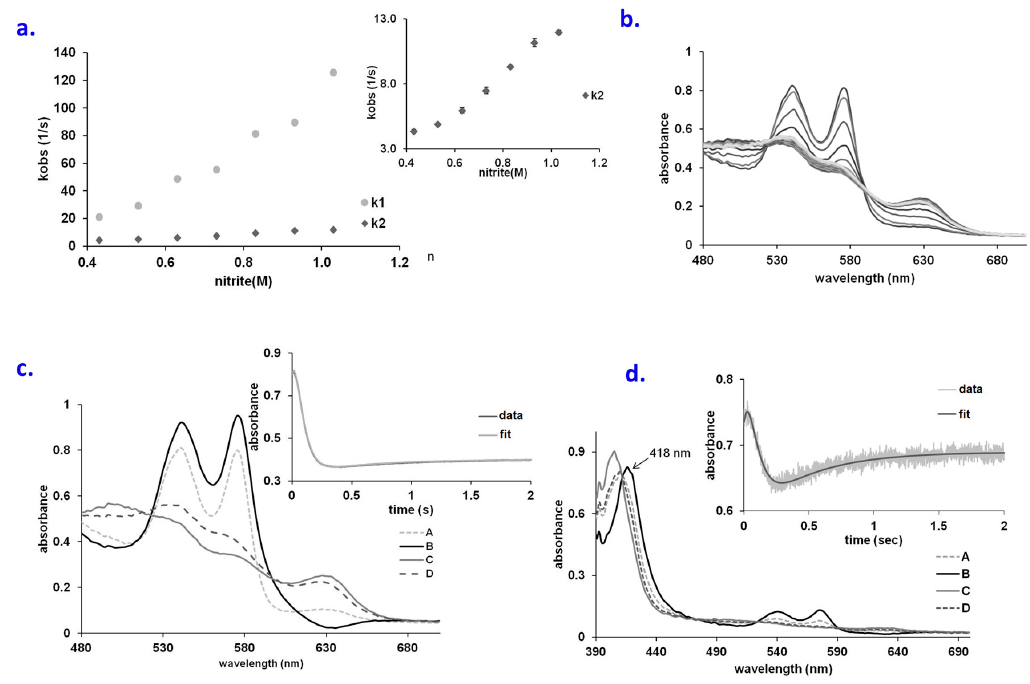
Figure 2. ( a ) Plots of k 1 and k 2 vs. NO 2 − concentration for the reaction of oxyHb with NO 2 − at pH 7.4, aerobic; ( b ) UV-vis spectra collected upon mixing oxyHb (66.6 µM) and guanidine (1M) with NaNO 2 (66 mM). Conditions: pH 7.4, PBS buffer, aerobic, over a range of 2 s; ( c ) Computed spectra for the species involved in the A → B → C → D reaction model (A—oxy Hb, B—Fe(II)-peroxynitrate, C- metHb, D—metnitriteHb). Conditions: 66.6 µM Hb, 1 M guanidine, 66 mM nitrite, pH 7.4, PBS buffer. Inset: fitting at 575 nm trace for the A → B → C → D kinetic model; ( d ) Computed spectra for the species involved in the A → B → C → D reaction model (A—oxy Hb, B—Fe(II)-peroxynitrate, C—